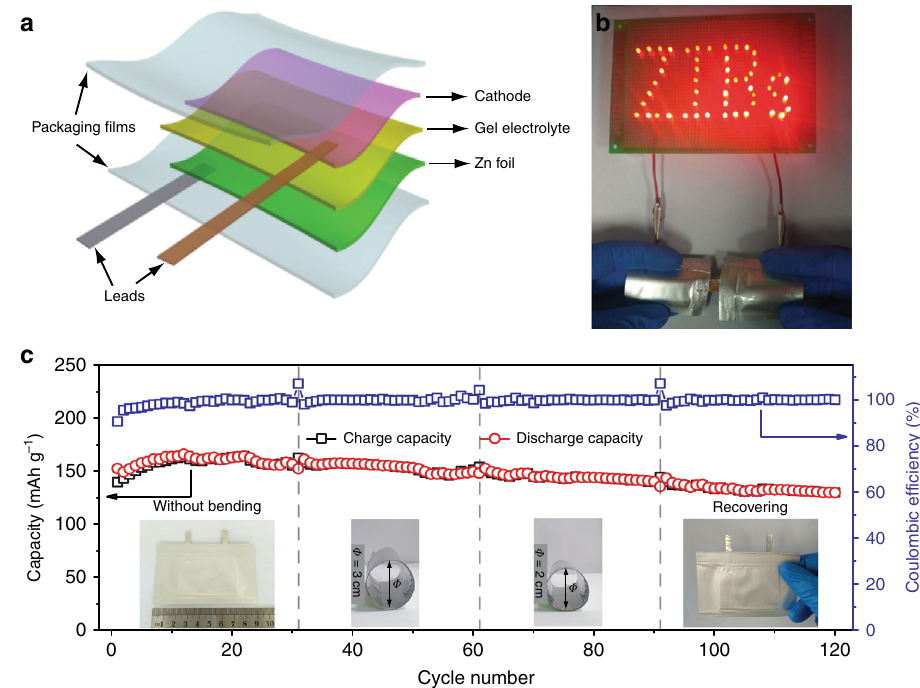
Fig. 6 Con fi guration and performance of fl exible quasi-solid-state Zn/NVO batteries. a Schematic diagram of a fl exible quasi-solid-state Zn/NVO battery. b LED array containing 52 bulbs powered by two fl exible quasi-solid-state Zn/NVO batteries under bending state. c Cycling performance under different bending states (0.5 A g – 1 ) of the fl exible quasi-solid-state Zn/NVO battery. The insets show the optical images of the quasi-solid-state Zn/NVO battery at corresponding bending